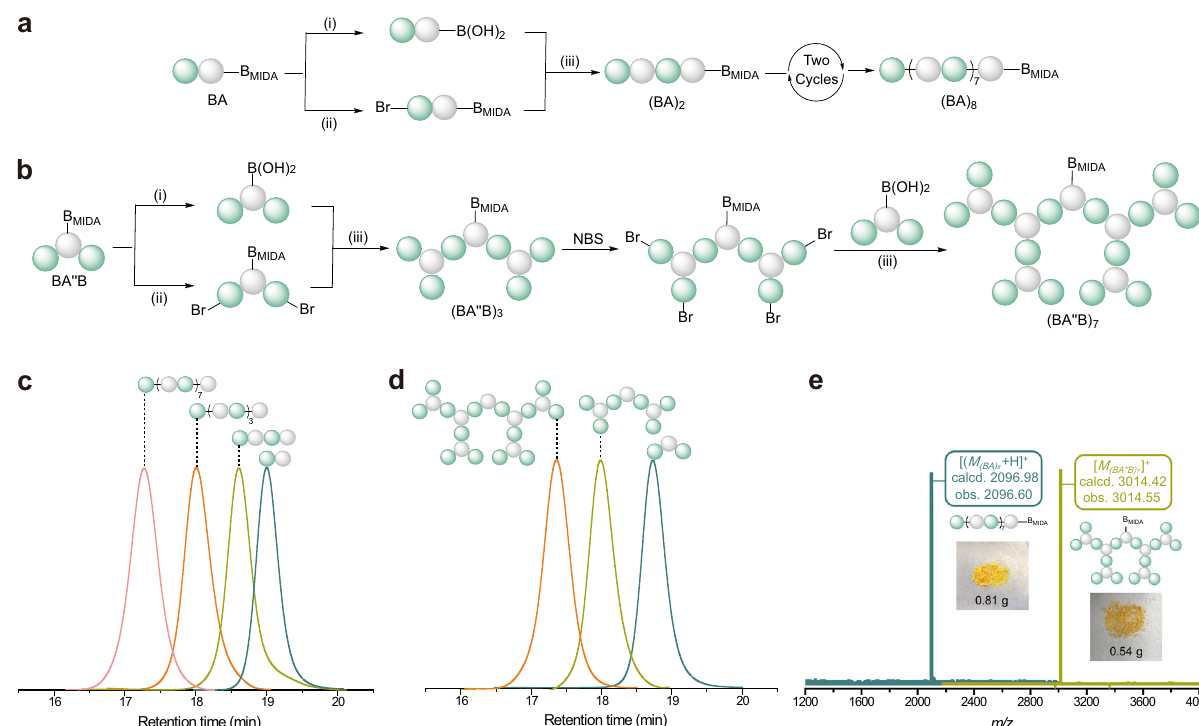
Fig. 5 Synthesis and characterization of linear and dendrimer-like star conjugated polymers. a Iterative exponential growth of BA-sequenced oligomer. b Iterative exponential and sequential growth of BA ″ B-sequenced oligomer. (i) Hydrolysis reaction (THF/NaOH aqueous solution); (ii) bromination reaction (NBS); (iii) Suzuki coupling reaction (Pd(OAc) 2 , RuPhos, and anhydrous THF, 70 °C). c GPC traces of BA-, (BA) 2 -, (BA) 4 -, and (BA) 8 -sequenced oligomers. d GPC traces of BA ″ B-, (BA ″ B) 3 -and (BA ″ B) 7 -sequenced oligomers. e MALDI-TOF overlapped spectra of (BA) 8 -sequenced oligomer and (BA ″ B) 7 -sequenced